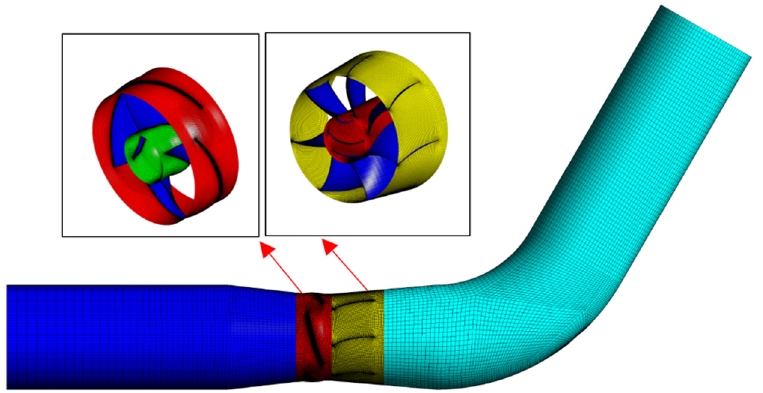
Figure 1. Overall 3D model drawing.1. Inlet pipe, 2. Impeller, 3. Guide vane, and 4. Outlet pipe .